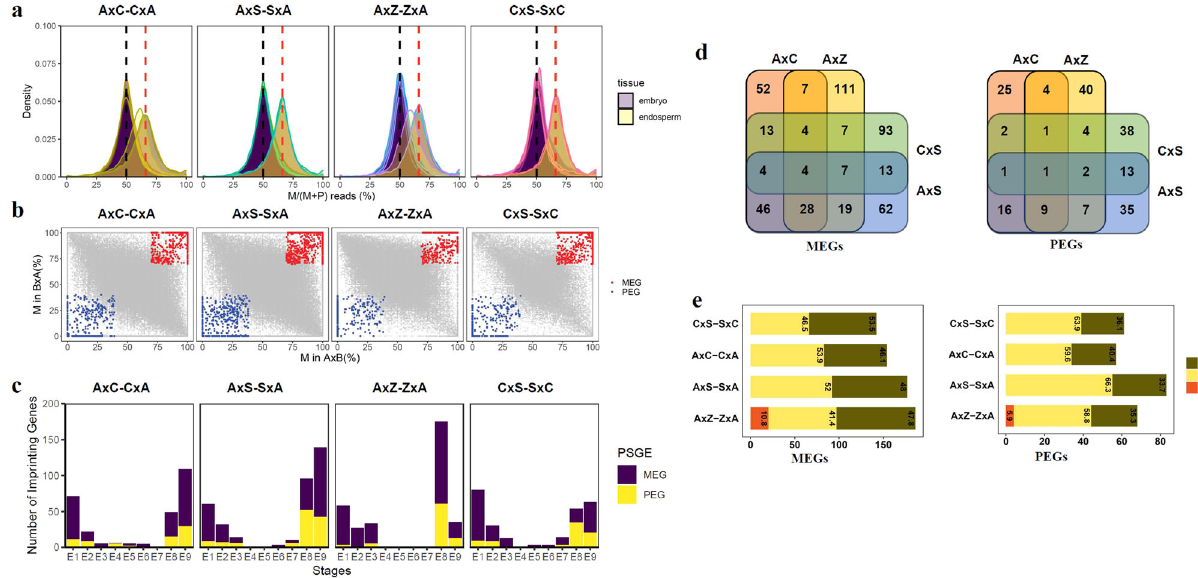
Fig. 6 Allele-speci fi c expression analysis in reciprocal crosses. a Distribution of the percentage of maternal alleles in each reciprocal cross pair in embryo and endosperm tissue. Maternal fraction of reads ( x -axis) are presented as percent of reads from maternal parent against read counts of the paternally and maternally derived reads in the reciprocal crosses, respectively. Black dash line represents 50% expected percent of maternal reads in embryos and red dash line denotes 67% expected percent of maternal reads in endosperm. b Allele-speci fi c expression analysis in each reciprocal cross pair. x -axis (percent of M in A×B) represents maternal fraction of reads for genes from A×C, A×S, A×Z, or C×S while y- axis represents maternal fraction of reads for genes (percent of M in BxA) from C×A, S×A, Z×A, and S×C, respectively. c Number of maternally expressed genes (MEGs) and paternally expressed genes (PEGs) identi fi ed at each stage in each cross pair. For embryos, MEGs or PEGs were identi fi ed as more than 70% of total SNP-containing reads that were maternally or paternally derived (FDR < 0.01). For endosperm, MEGs were identi fi ed as more than 85% of total SNP-containing reads that were maternally derived while PEGs were identi fi ed as more than 60% of total SNP-containing reads that were paternally derived (FDR < 0.01). d Venn diagrams of imprinted genes identi fi ed from A×C and C×A, A×Z and Z×A, A×S and S×A, and C×S and S×C reciprocal cross pairs. e Distribution of imprinted genes on A, B, and D genomes in reciprocal